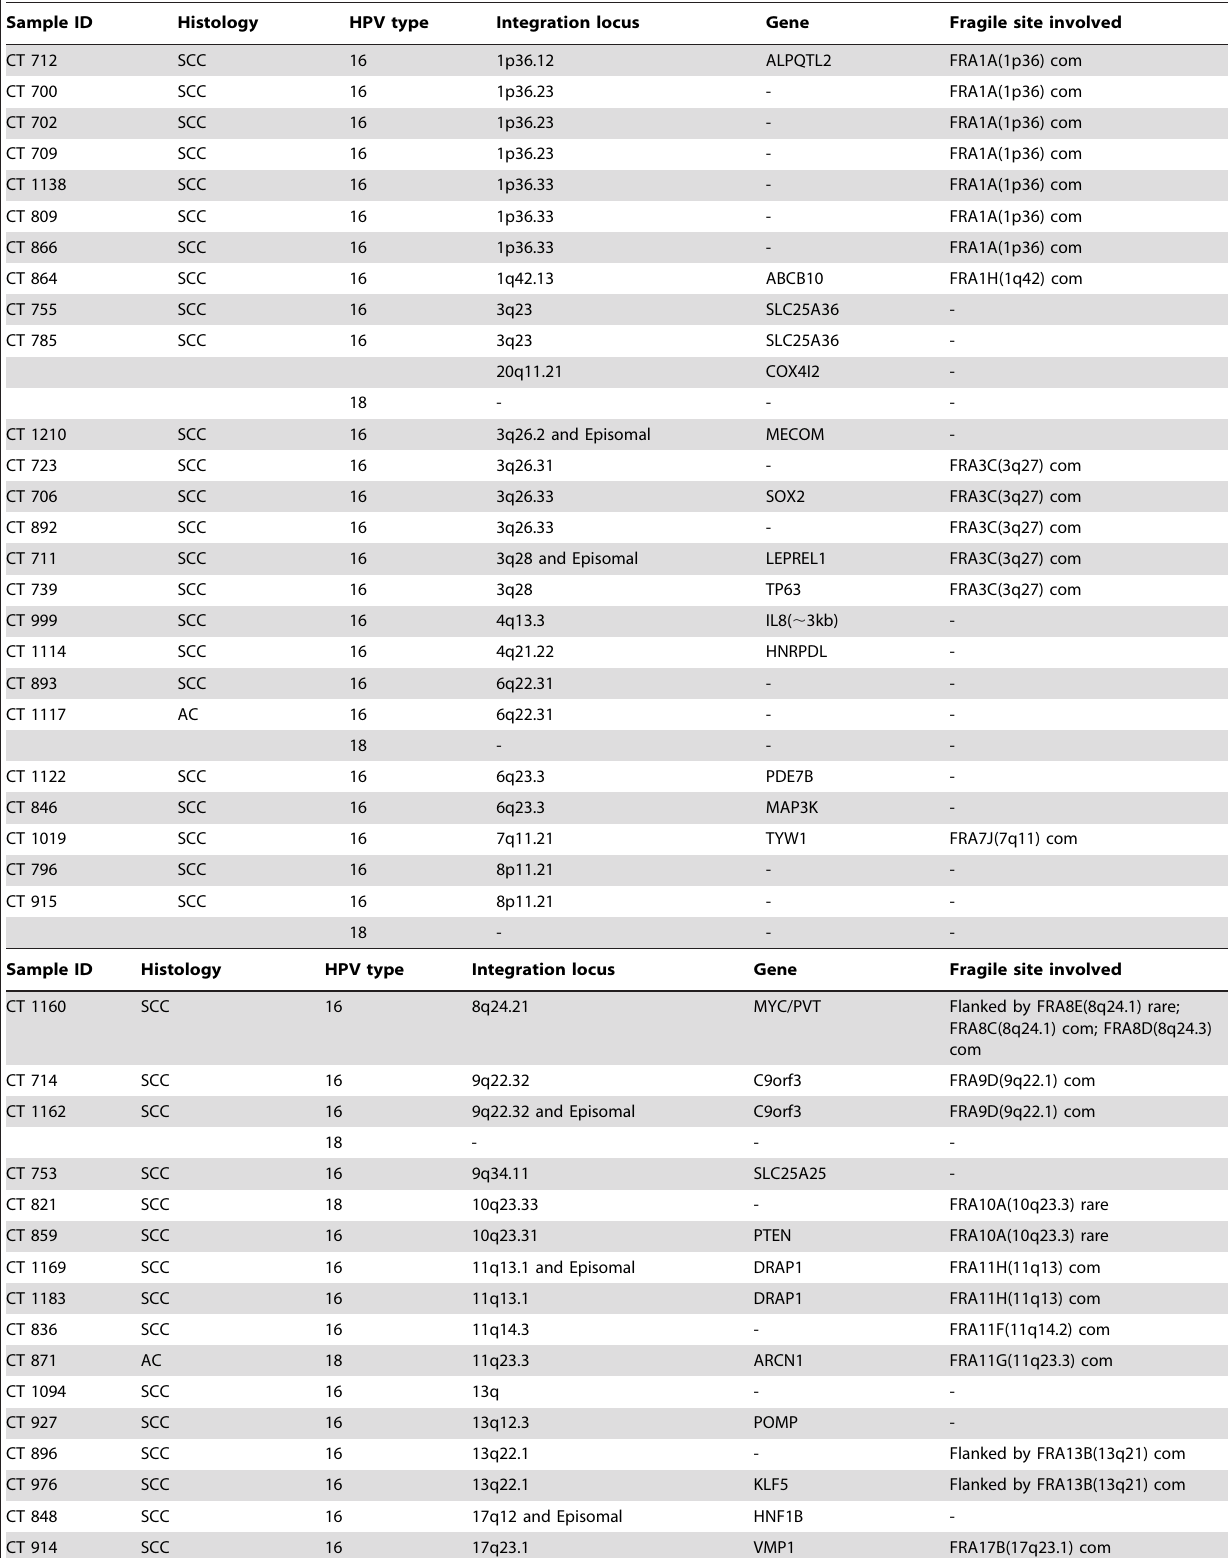
Table 1. Summary of HPV Integration